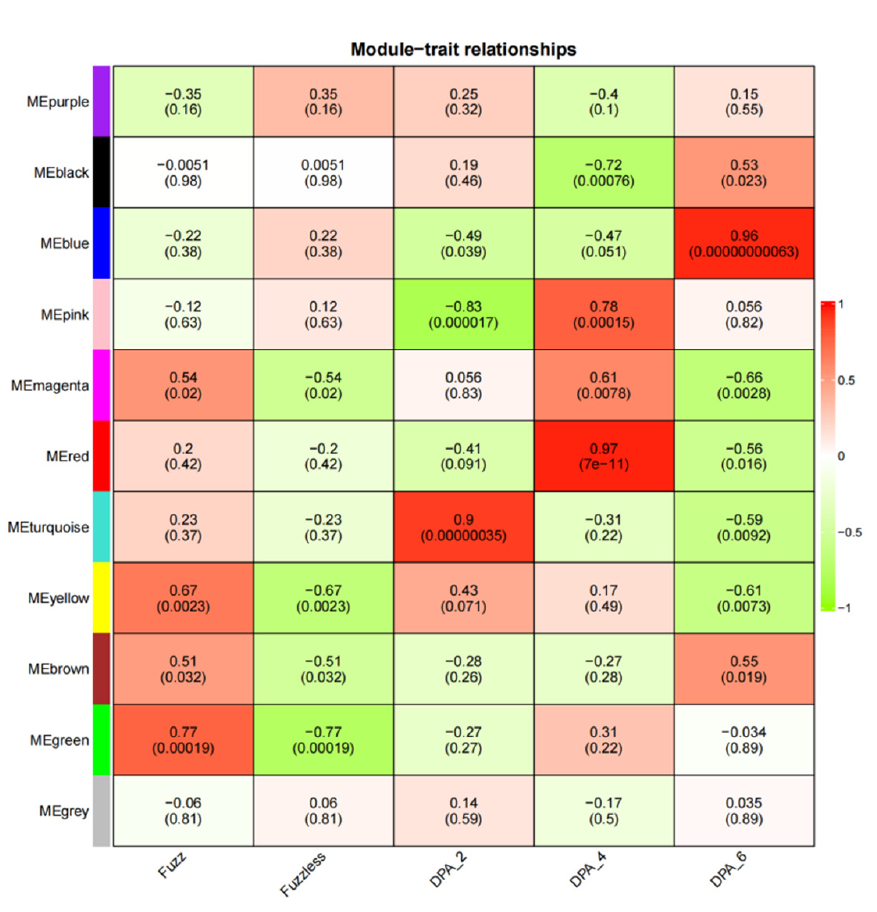
Figure 10. Heatmap of correlation between modules and traits. Numbers in squares represent correlation coefficients and p -values between modules.